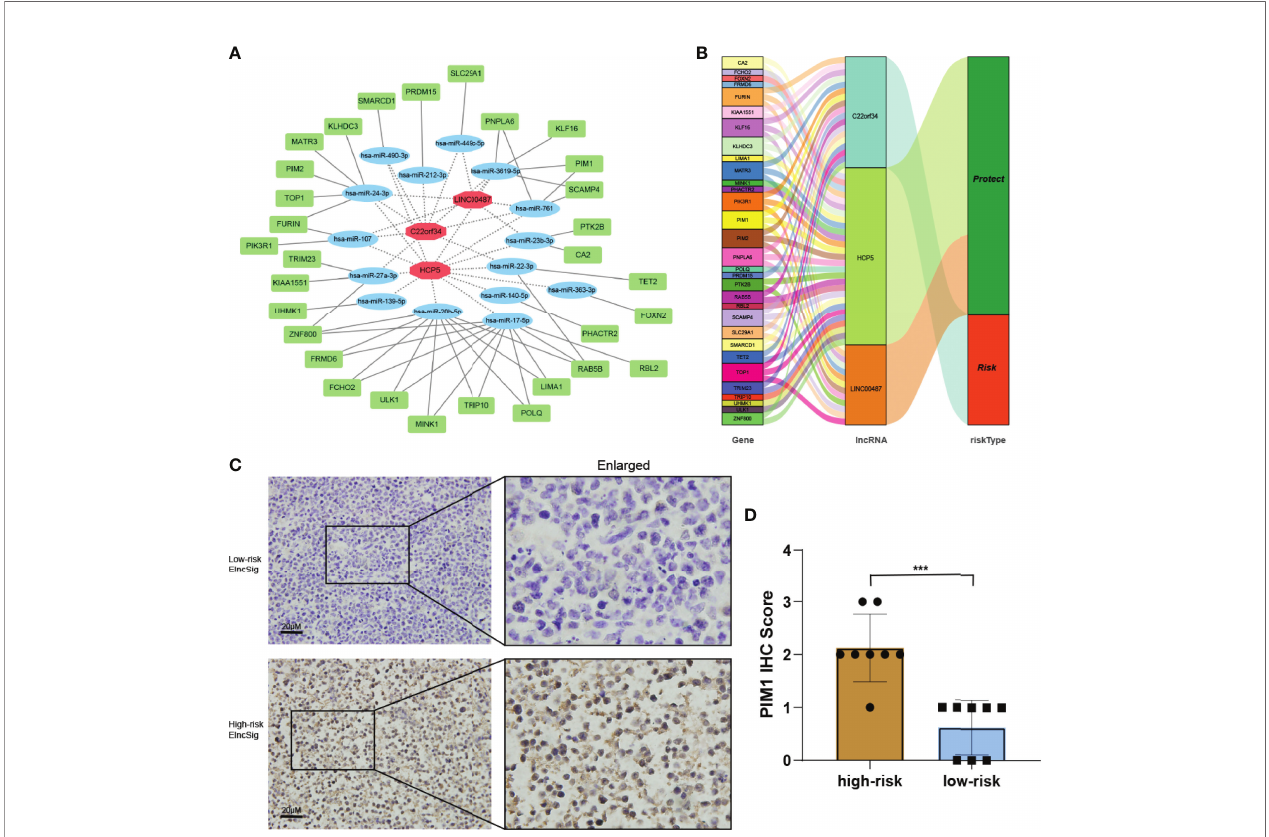
FIGURE 8 | Co-expression network and validation of prognostic ELncSig lncRNAs and the associated genes. (A) A co-expression network of ELncSig lncRNAs and mRNAs was constructed and visualized using Cytoscape. The red hexagons indicate prognostic lncRNAs, and the green rectangles indicate ELncSig mRNAs. (B) Sankey diagram showing the associations between prognostic ELncSig lncRNAs, mRNAs, and risk type. (C, D) Immunohistochemical images and differential analysis of PIM1 in high- and low- risk ELncSig (***p < 0.001, by Student's